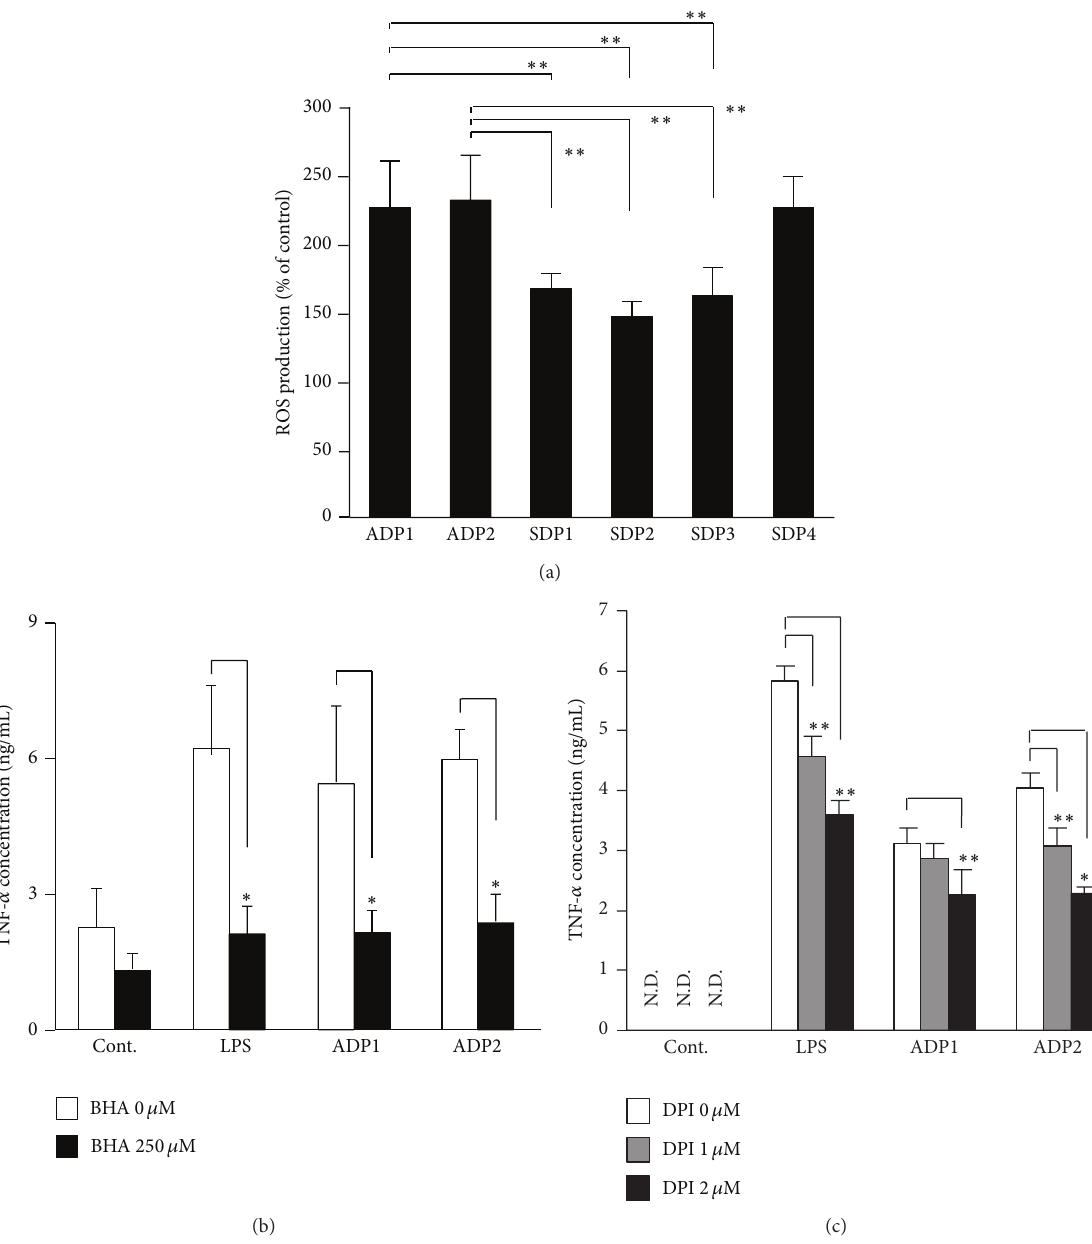
Figure 4: Asian dust particles-induced reactive oxygen species (ROS) production mediates tumor necrosis factor- 𝛼 (TNF- 𝛼 ) production in RAW264.7 cells. (a) RAW264.7 cells were incubated in phenol red-free Dulbecco’s modified Eagle’s medium containing 20 𝜇 M 2 󸀠 ,7 󸀠 - dichlorodihydrofluorescein diacetate for 30min. The cells were then treated for 6h with 100 𝜇 g/mL of one of the Asian dust particles (ADP1 or ADP2) or soil dust samples (SDP1, SDP2, SDP3, and SDP4) or culture medium. ROS production was measured as the fluorescence intensity of dichlorodihydrofluorescein. (b, c) RAW264.7 cells were preincubated for 30 min with (b) 250 𝜇 M of butylated hydroxyanisole (BHA), a broad-spectrum ROS scavenger, or (c) 1 or 2 𝜇 M of diphenyleneiodonium chloride (DPI), a specific inhibitor of NADPH oxidase. The cells were then treated for 6 h with 100 𝜇 g/mL of ADP1 or ADP2 or 1.5 𝜇 g/mL of LPS. Dimethyl sulfoxide (0.1%) vehicle was used as control (Cont.). The level of TNF- 𝛼 in the culture supernatants was assessed by means of an enzyme-linked immunosorbent assay. Results are expressed as mean ± SD; 𝑛 = 6 ; ∗∗ 𝑃 < 0.01 ; N.D., not